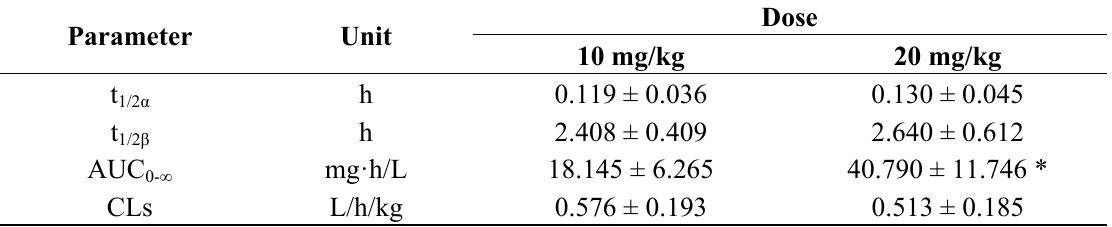
:elimination phase; AUC 1/2 β